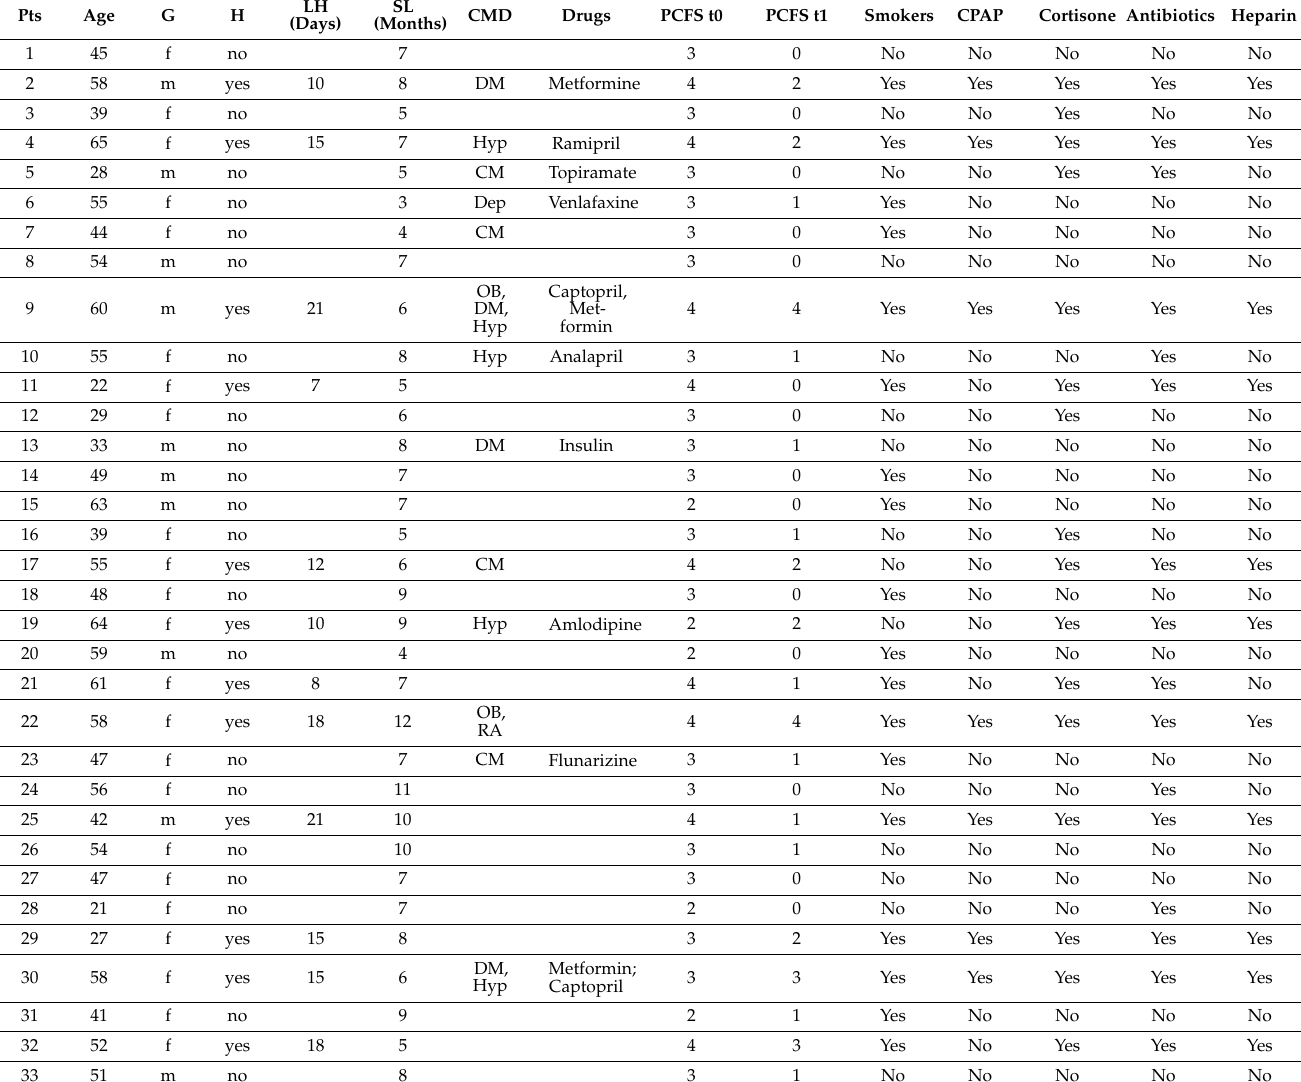
Table 1. Long COVID Patients’ demographic and clinical